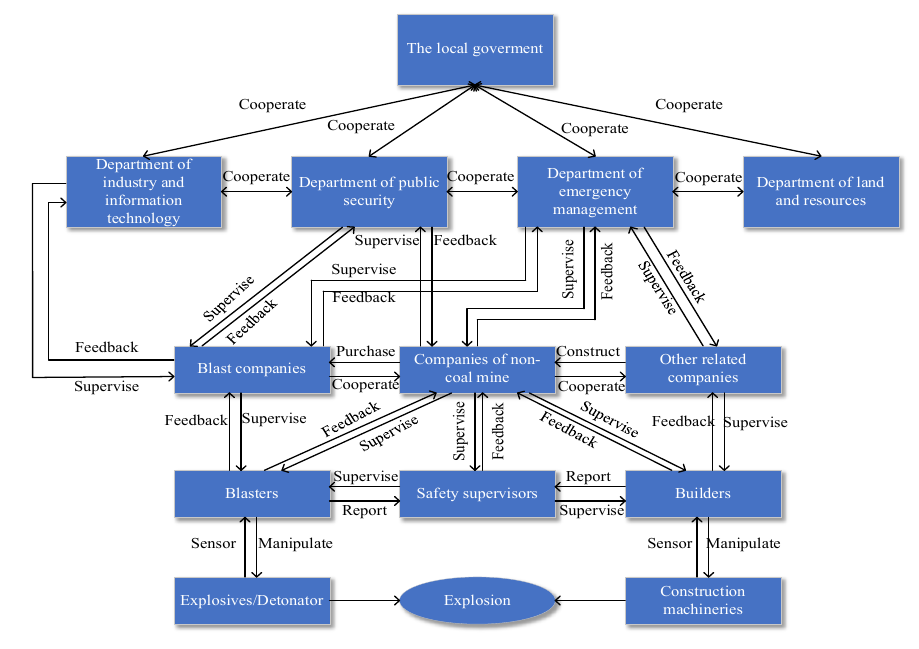
Tips: The rectangles represent the controller; The ellipse represent event Figure 5. Hierarchical safety control structure of non-coal mine explosion accidents.